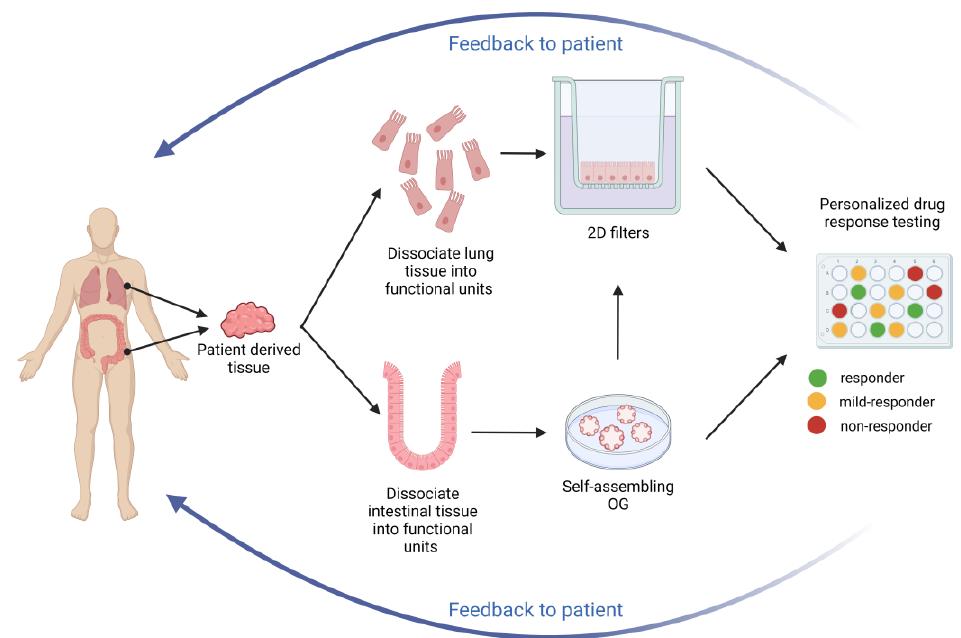
Figure 2. Theratyping strategies. Nasal and intestinal biopsies can be collected and utilized to derive long-term cultures that can be utilized for functional assays measuring CFTR function, as described in the text. The results can inform the clinician on the response of the specific CFTR variants and combinations expressed by the proband thus providing directions on the choice of the most appropriate treatment.